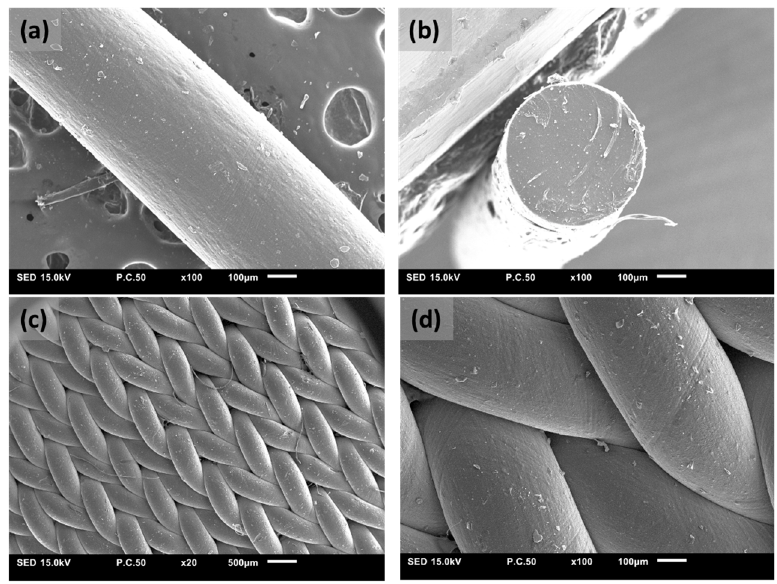
Figure 1. ( a ) Surface morphology of a conductive silicone rubber (CSR) yarn characterized by SEM; ( b ) Cross-section morphology of a CSR yarn; ( c ) Morphology of a dry textile electrode made of CSR yarn at 20× magnification; ( d ) Morphology of a dry textile electrode made of CSR yarn at 100× magnification.